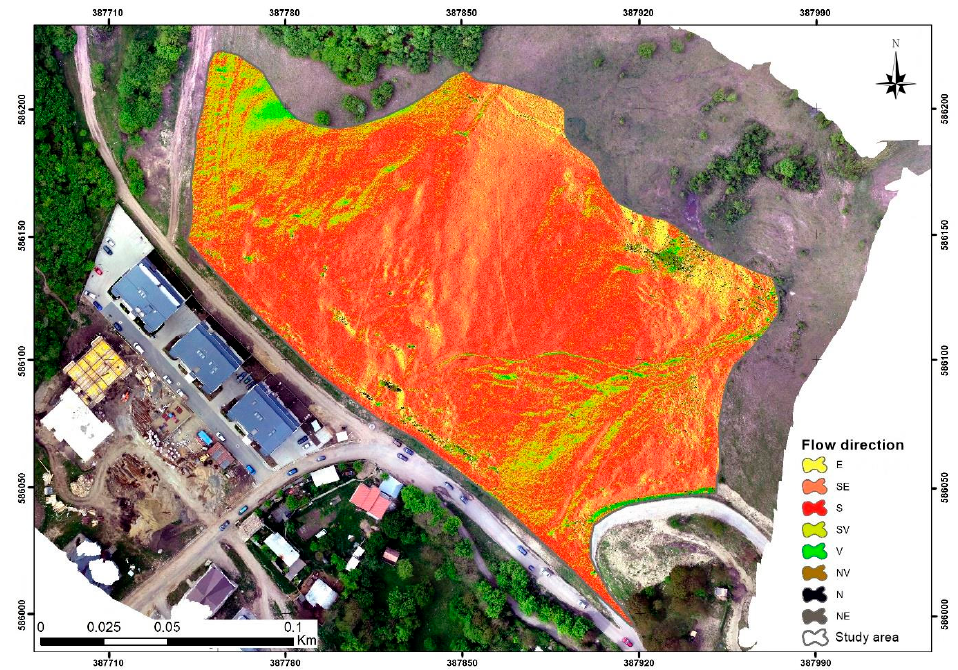
Figure 17. Flow direction of the study